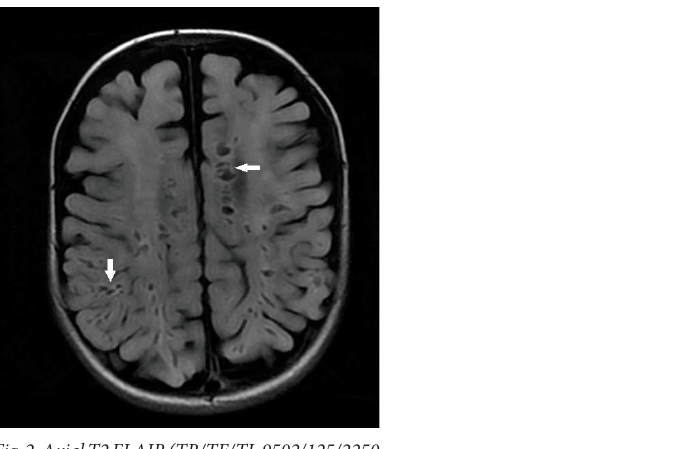
Fig. 2. Axial T2 FLAIR (TR/TE/TI, 9502/125/2250 ms) image at the level of the fronto-parietal lobes shows the cribriform pattern (arrows) of enlarged perivascular spaces in the subcortical and deep white matter and centrum semiovale.